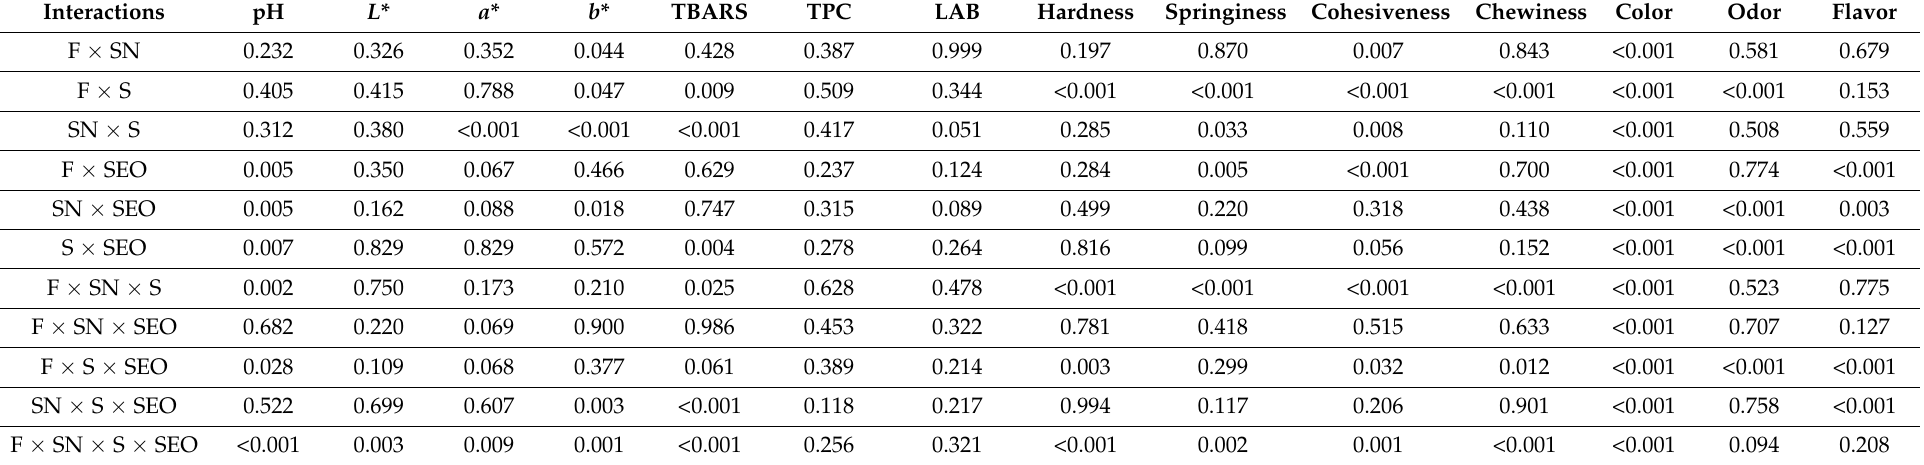
Table 4. The effect of two-way, three-way and four-way interactions among processing parameters on the quality of DFS, expressed as p -value.